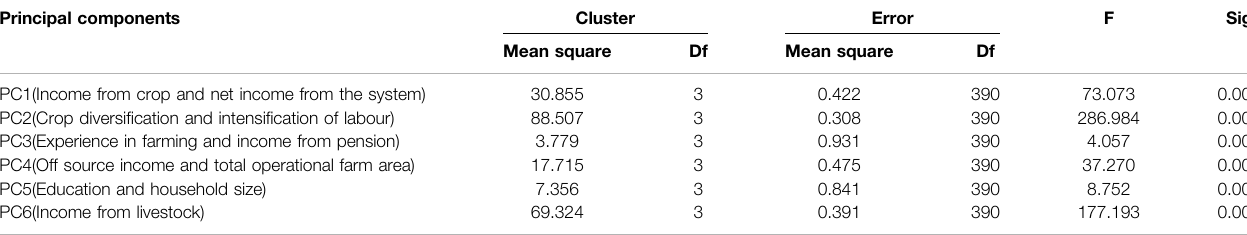
PC1(Income from crop and net income from the